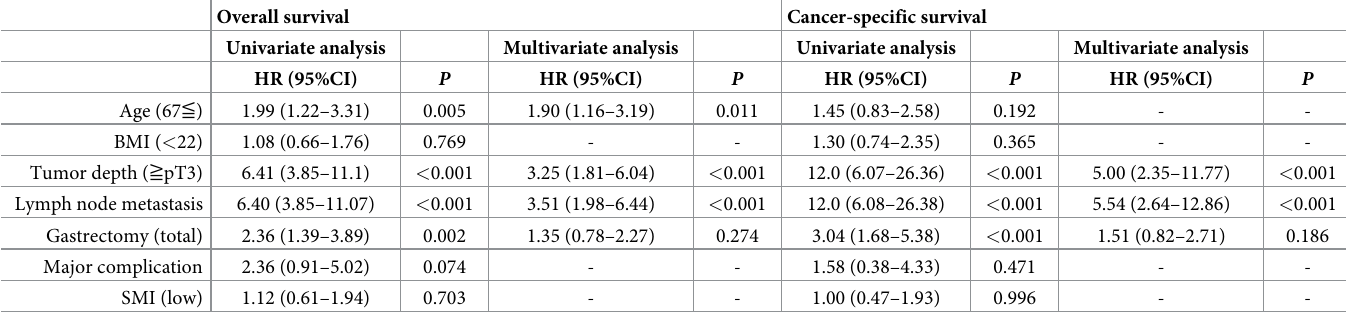
Table 4. Univariate and multivariate analysis of overall survival and cancer-specific survival in women. Overall